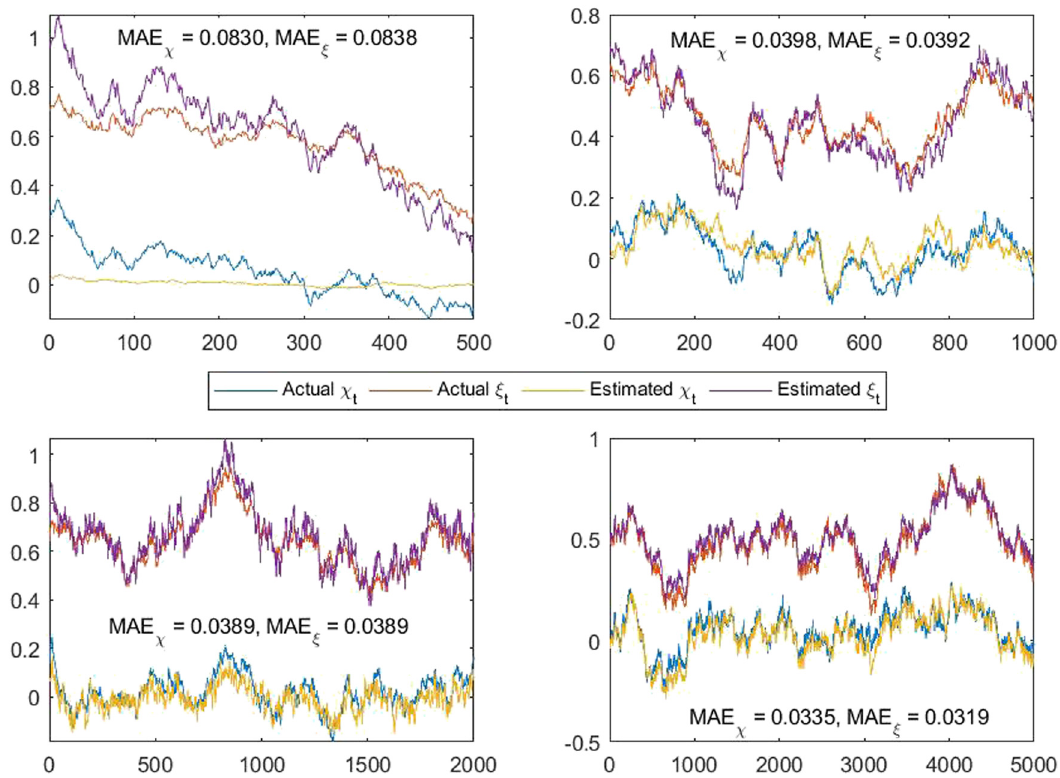
and ξ versus = n 500 , 1,000, 2,000, 5,000, and MAE for two factors, starting from top - left to t t